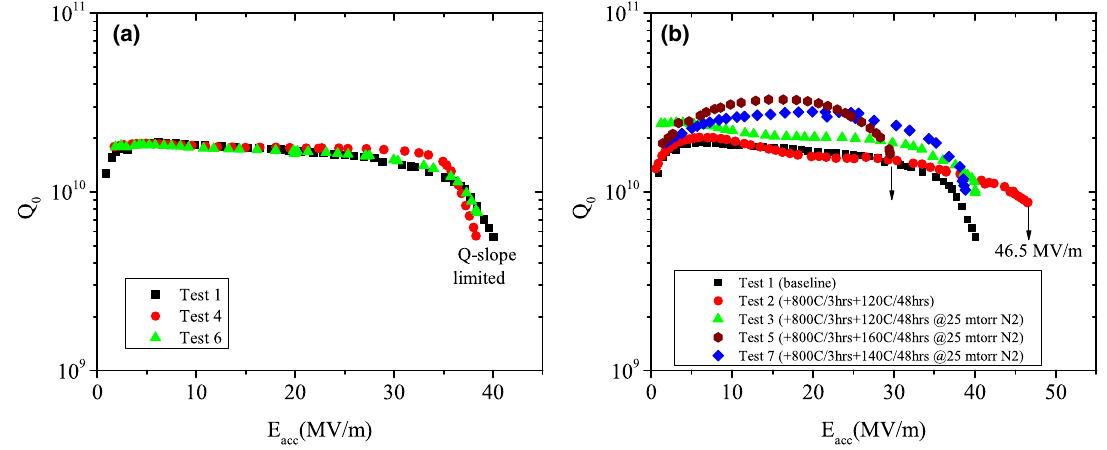
FIG. 3. Radio frequency measurement taken at 2.0 K for (a) the baseline measurements and (b) after different surface treatments.